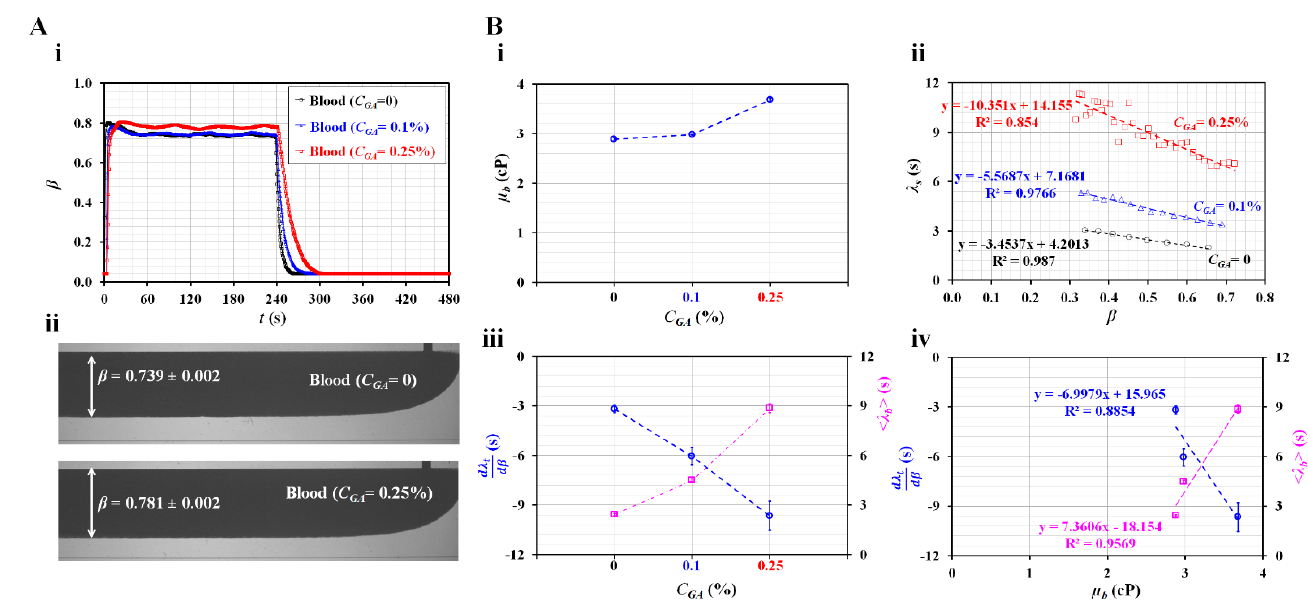
Figure 6. Quantification of haemorheological properties of hardened RBCs. ( A ) Variations in the interface with respect to concentration of GA solution. ( i ) Temporal variations in β with respect to the concentration of GA solution ( C GA = 0, 0.1%, and 0.25%). ( ii ) Microscopic images of the interface with respect to C GA . ( B ) Quantification of viscosity and time constant of hardened RBCs. ( i ) Variations in µ b with respect to C GA . ( ii ) Variations in λ b with respect to β and C GA . ( iii ) Variations in 𝑑𝜆 𝑡 𝑑𝛽 and < λ t > with respect to C GA . ( iv ) Variations in 𝑑𝜆 𝑡 𝑑𝛽 and < λ t > with respect to µ b